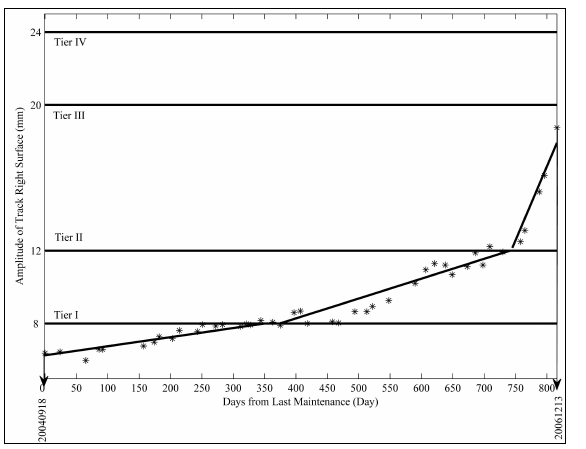
Figure 1 Actual Performance Graph of Track Gauge at Mileage Point K423+725 in Jing-Hu Down-going Track